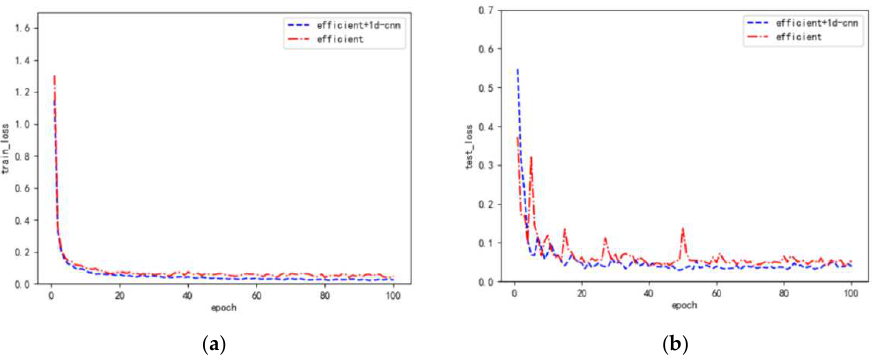
Figure 4. Comparison of some experimental performance data of the proposed method. ( a ) Loss change of the training set. ( b ) Loss change of the validation set.